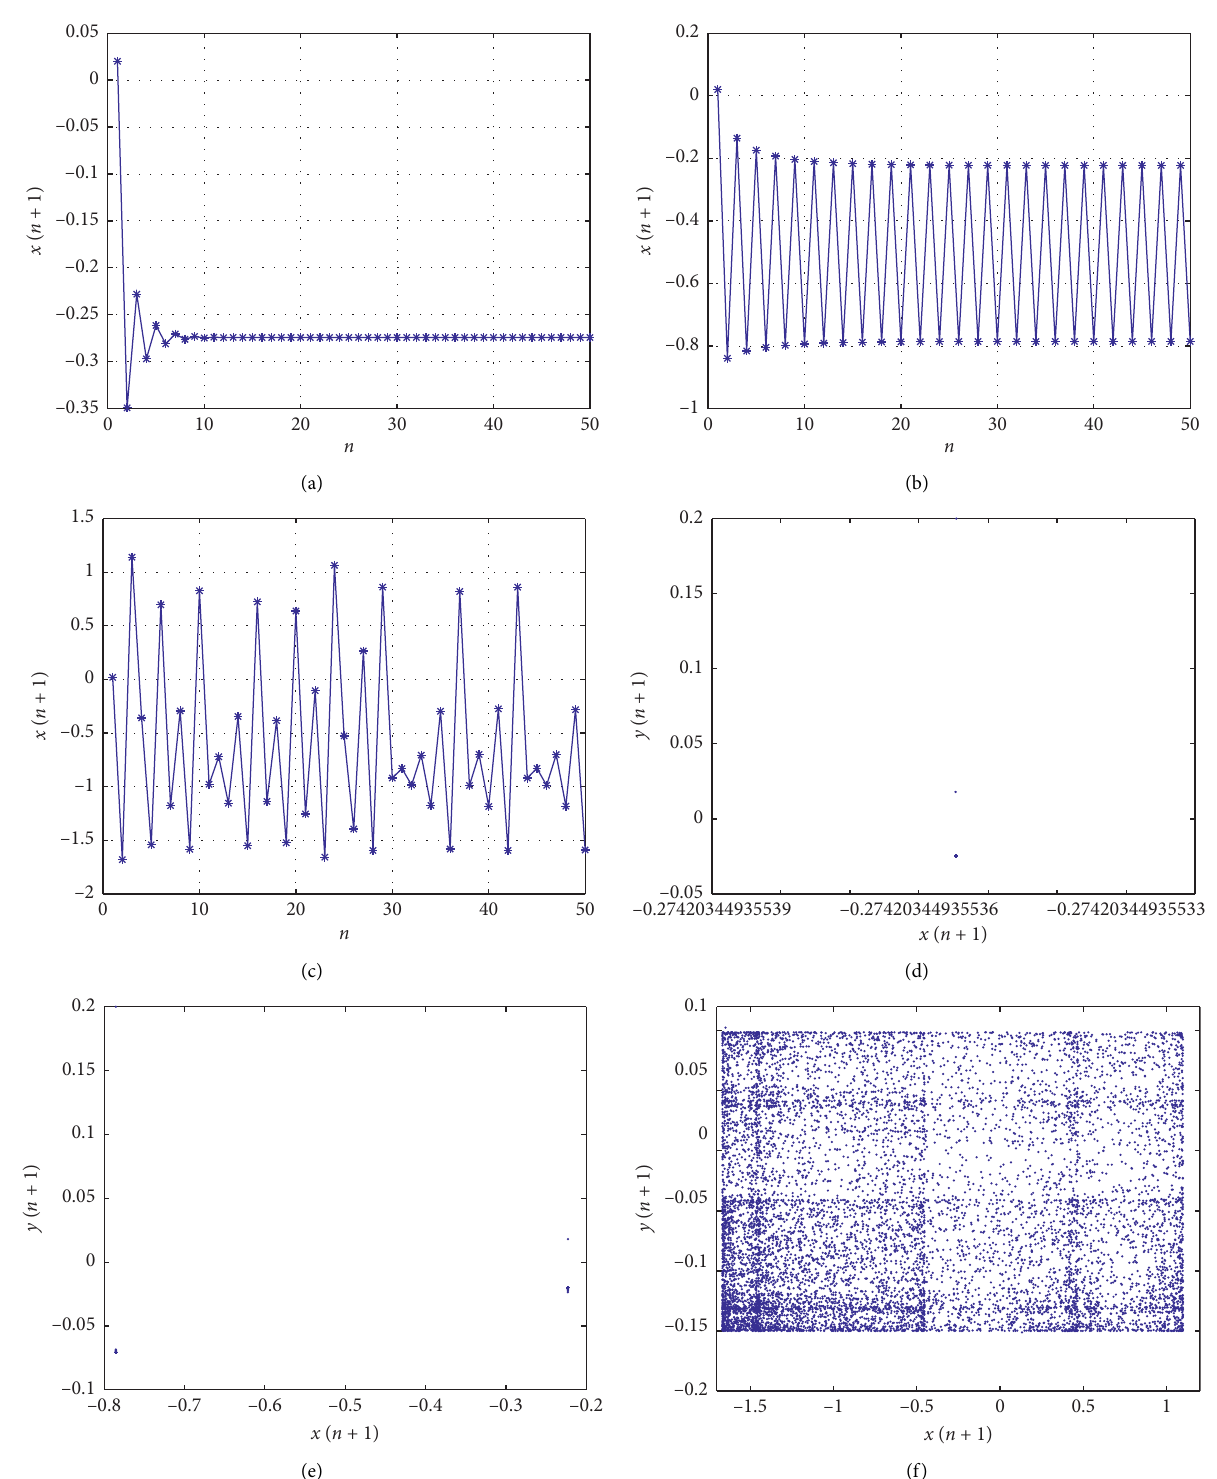
Figure 4: Iteration and trajectory analyses of the first proposed chaotic map at x r � 0.6, and (c) r � 1.2. Trajectory property at (d) r � 0.25, (e) r � 0.6, and (f) r �